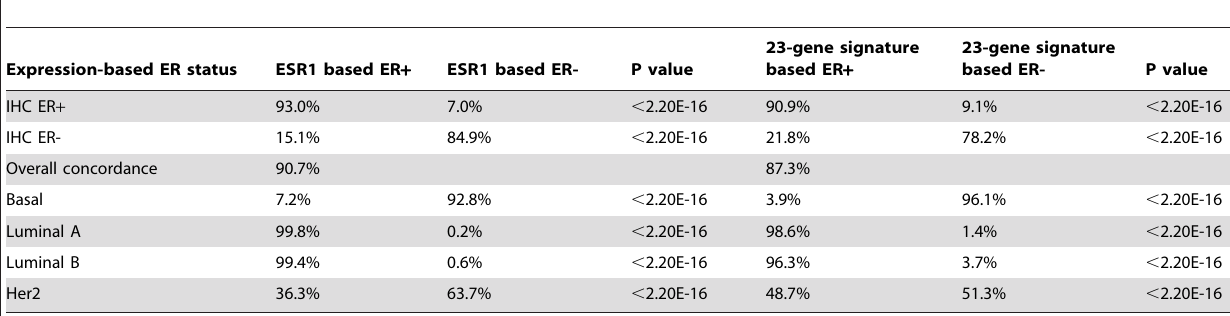
Table 2. Comparison of ER status determined by microarray-based classifiers to the ER status based on conventional IHC method in 1846 samples from 10 published data